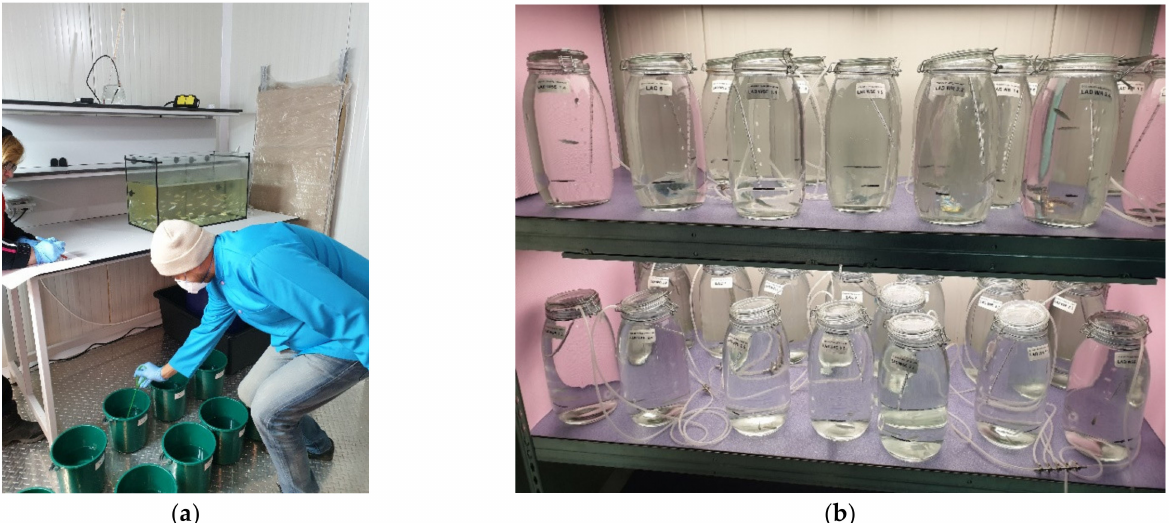
Figure 3. ( a ) Fish batch randomization using plastic buckets; after reaching the desired number [4] of individuals per bucket, the contents of each bucket were strained through a net and all fish were transferred to the matching labeled experimental jar; ( b ) Experimental jars randomized on the rack in the temperature-controlled room (original